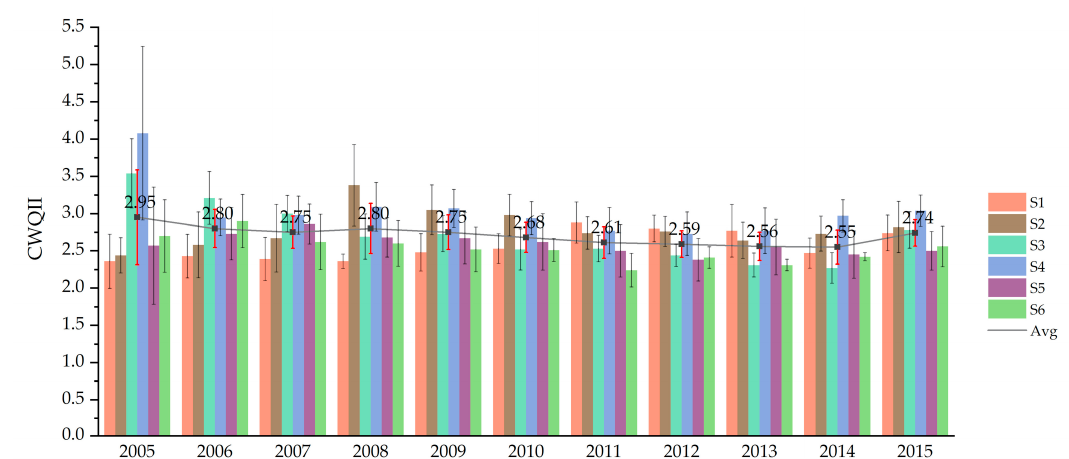
Figure 4. The yearly CWQII of each site in Xuzhou section. The standard deviation error bars were added in the figure. The two decimal places of the CWQII only represented the calculation results of mean values, and the second decimal place was irrelevant to the significance of X3 in CWQII.